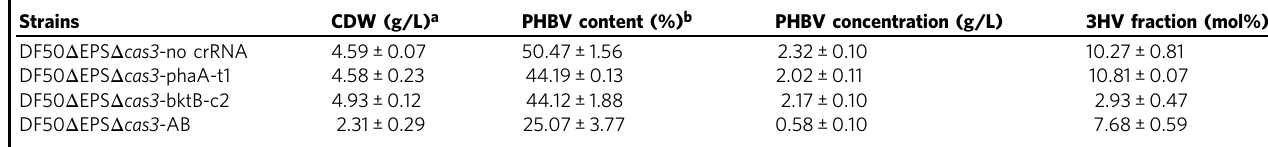
All data are expressed as mean±standard deviations from three independent experiments. a CDW, dry weight of the cell (in grams) produced per liter of culture. b PHBV content, the weight percent of PHBV in